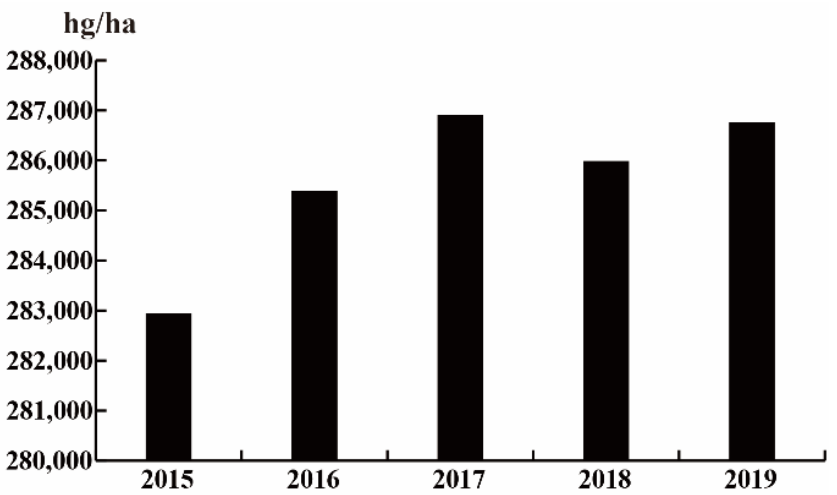
Figure 1. Changes in the cultivated area of cruciferous vegetables in recent years.